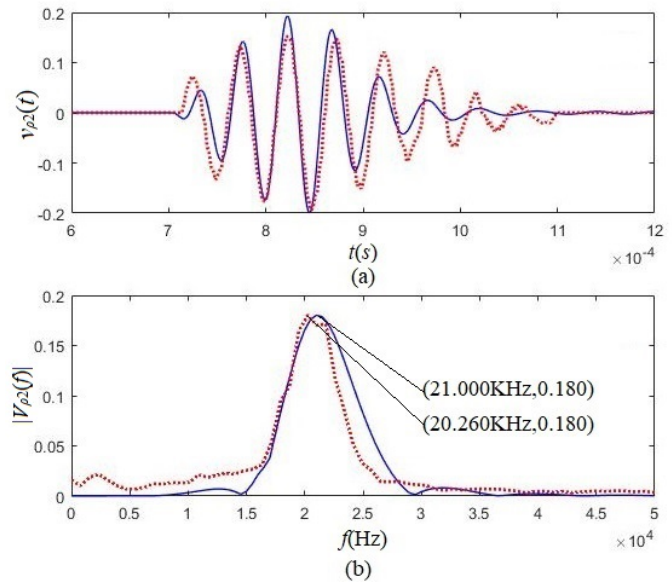
Figure 13. The calculated waveforms and amplitude spectrum and the experimental results used two radially polarized transducers. The solid lines are theory calculation results, and the dotted lines are experiment measurement results. ( a ) Waveforms; ( b ) amplitude spectra.